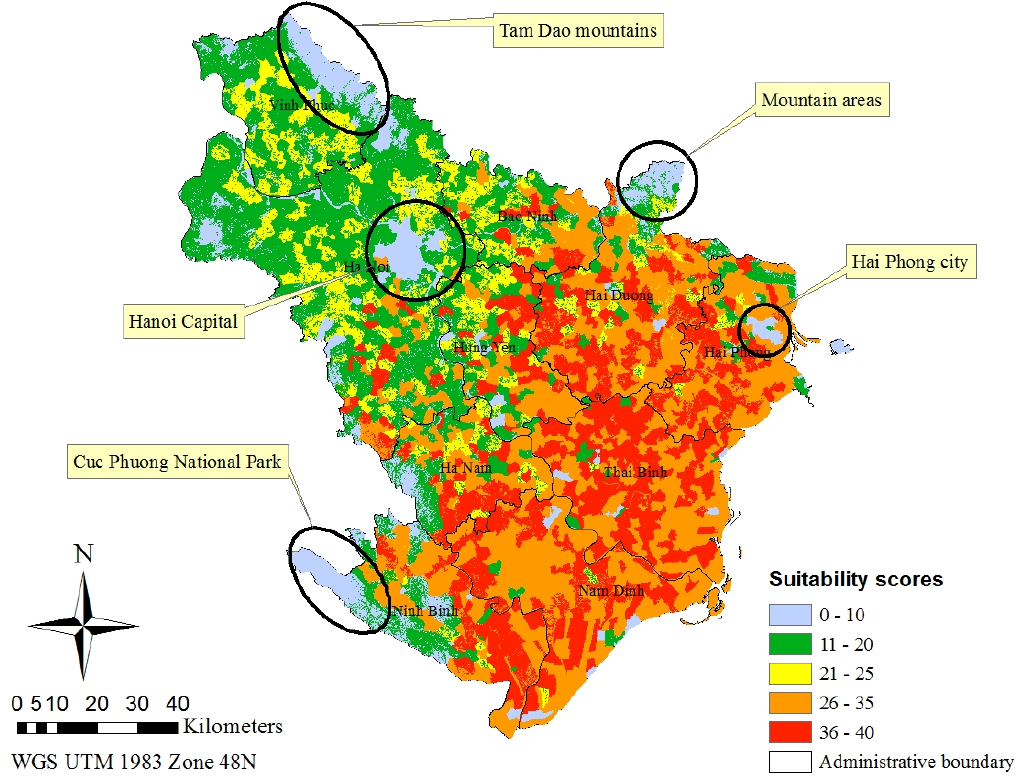
Figure 3. Weighted overlay analysis results for the HPAI H5N1 occurrence in the Red River Delta. The highest suitability score areas were shown in red, followed by orange. Yellow, green, and blue areas have lower suitability scores. These areas (suitability scores ranging from 0–10, 11–20, and 21–25, respectively) were mostly located to the west and northwest of the Red River Delta. The areas with high suitability scores (ranging from 26–40), as shown in red and orange, were chosen as the focus areas for the alternative vaccination program against HPAI